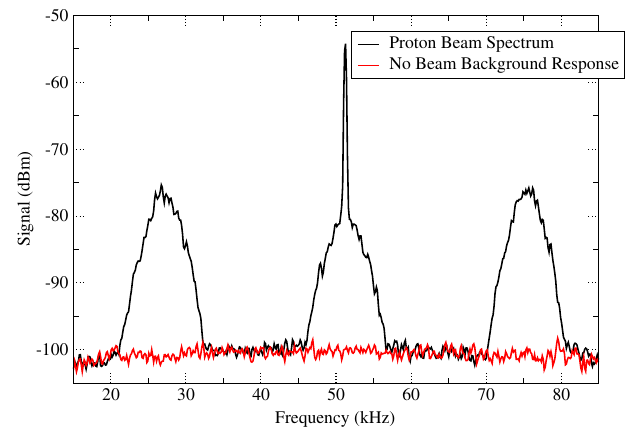
FIG. 4. (Color) A Schottky spectrum and background spectrum taken during normal polarized protons operation.